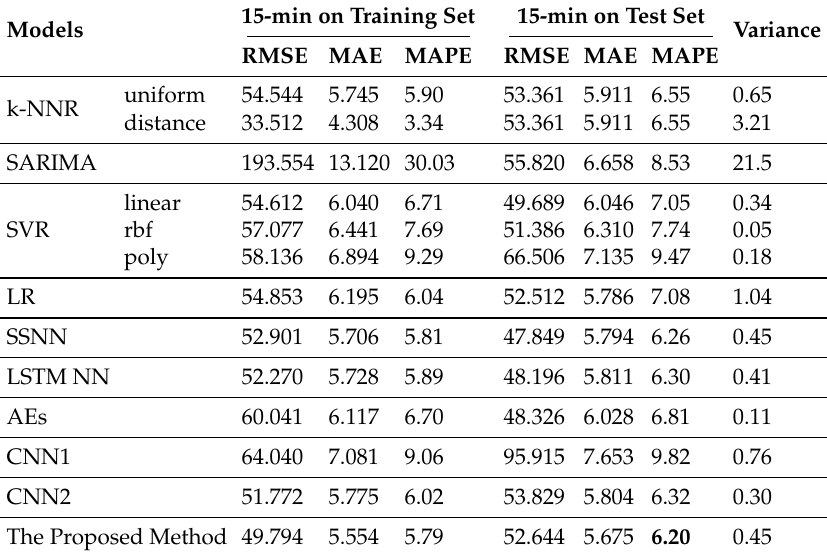
Table 4. Experimental results of the proposed method and the baseline methods on link AL282. The best results in the table appear in bold.